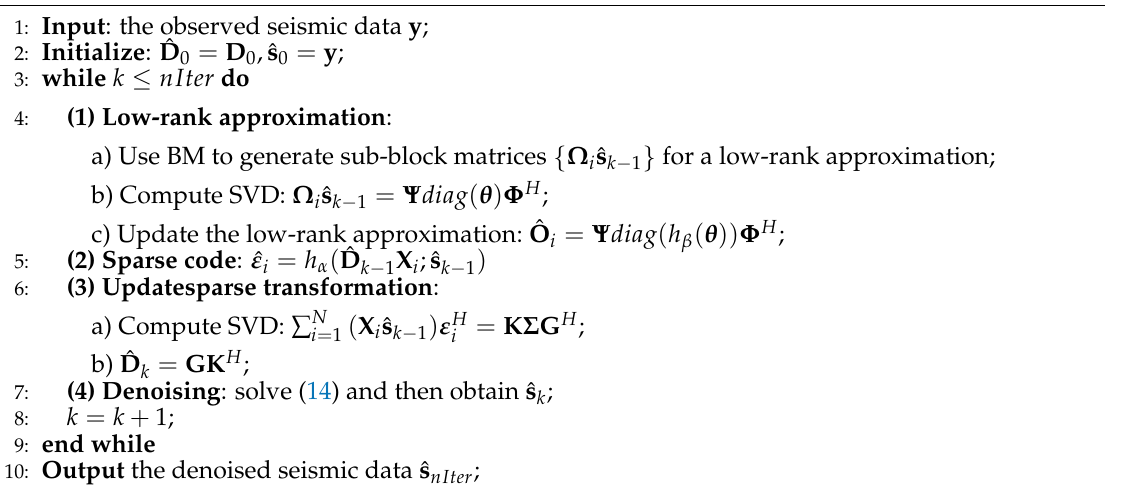
Algorithm 1 Seismic denoising based on sparsity and low-rank regularization